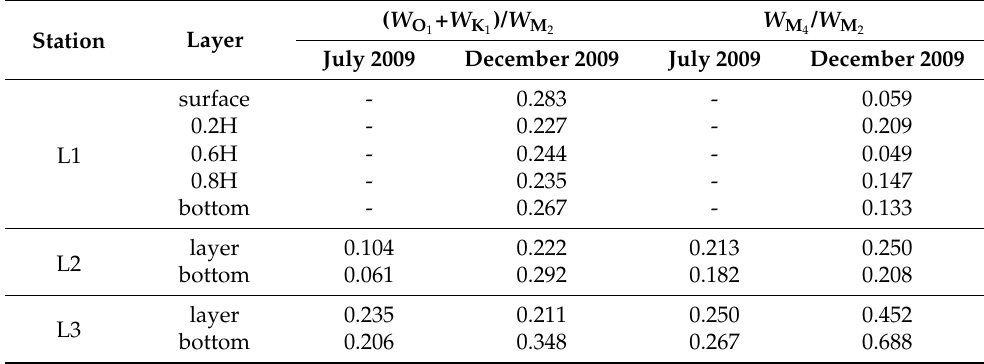
Table 3. Tidal current eigenvalue ( W O current ellipse of O 1 , K 1 and M 1